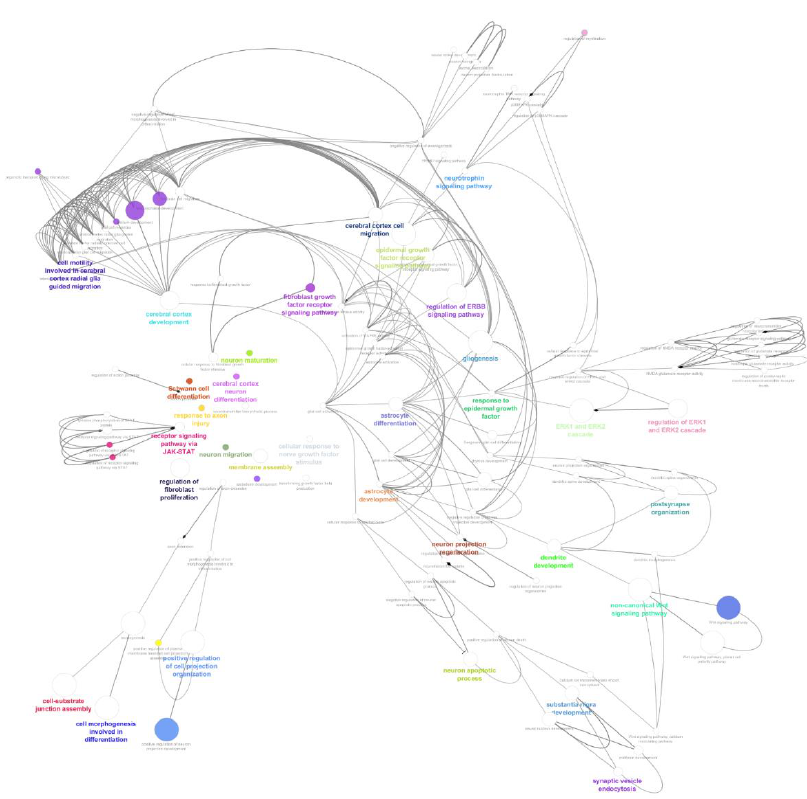
Figure 5. The ClueGo analysis of clustered proteins within each GO node for biological process interaction and signalling pathway analysis involved in the VPA treated cells. Node sizes are relative to number of proteins in dataset identified in that GO. Coloured nodes and labels represent important GO terms in the network.